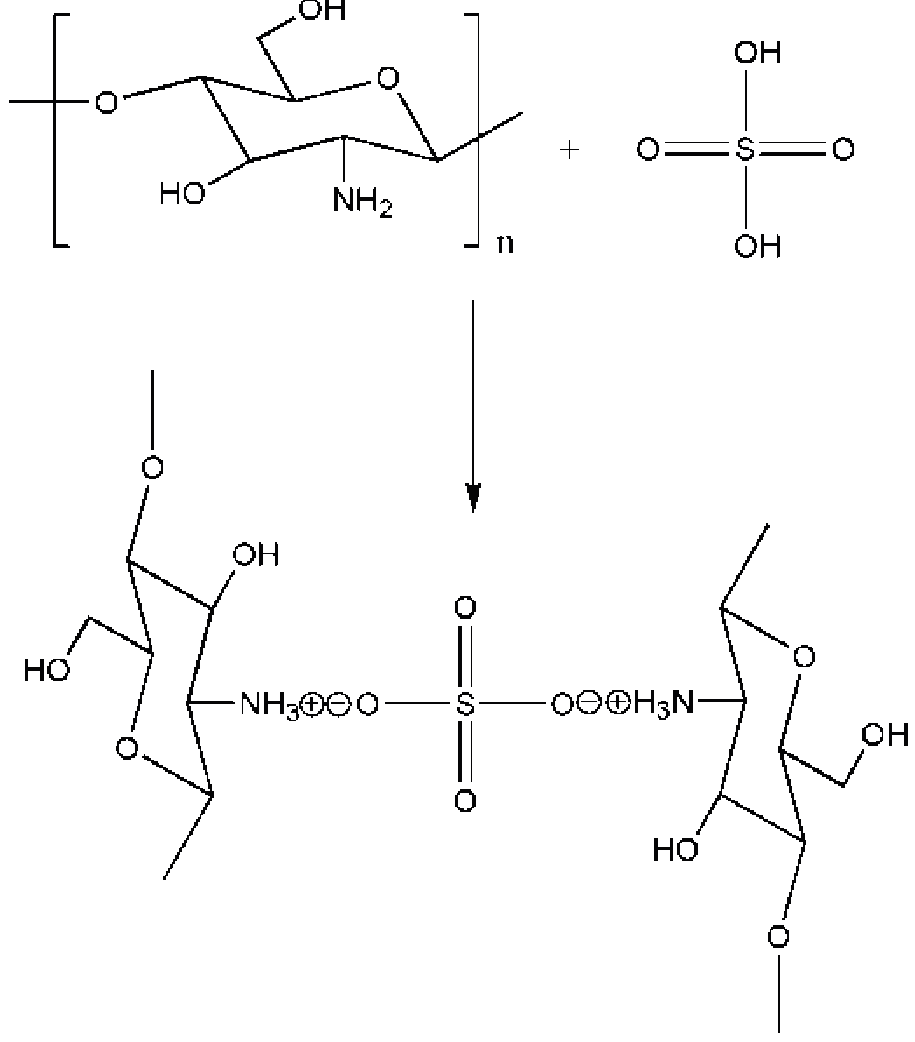
Figure 9. Cross-linking mechanism of chitosan and sulfuric